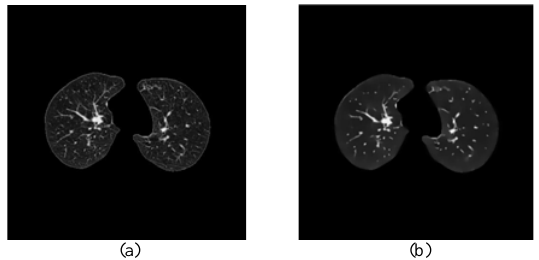
Fig. 5. The filtering result of pulmonary parenchyma using nonlinear anisotropic diffusion filtering. (a)segmentation of lung, (b)the filtering